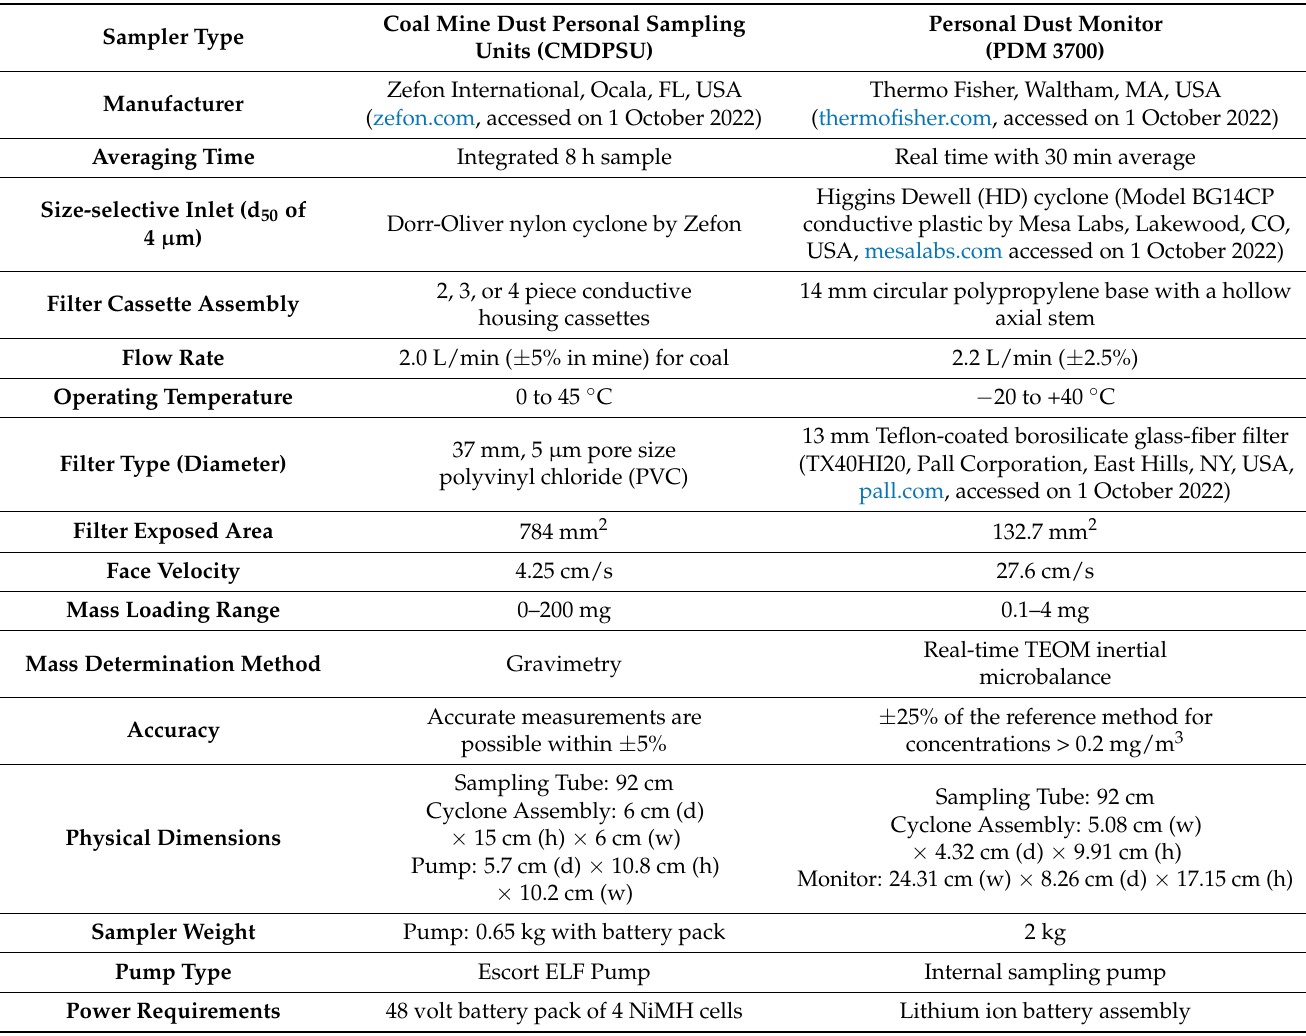
Table 1. Specification of MSHA coal mine dust monitors